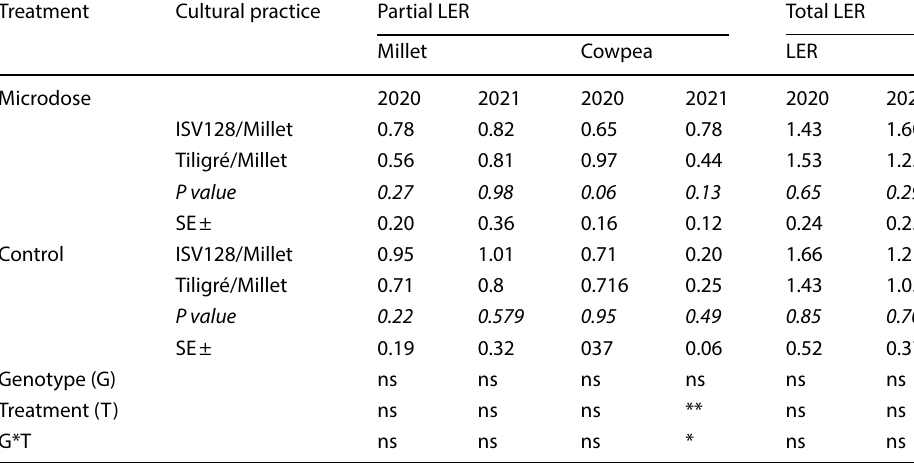
Table 4 Partial and total LER of millet and cowpea as affected by intercropping and microdose fertilizer in 2020 and